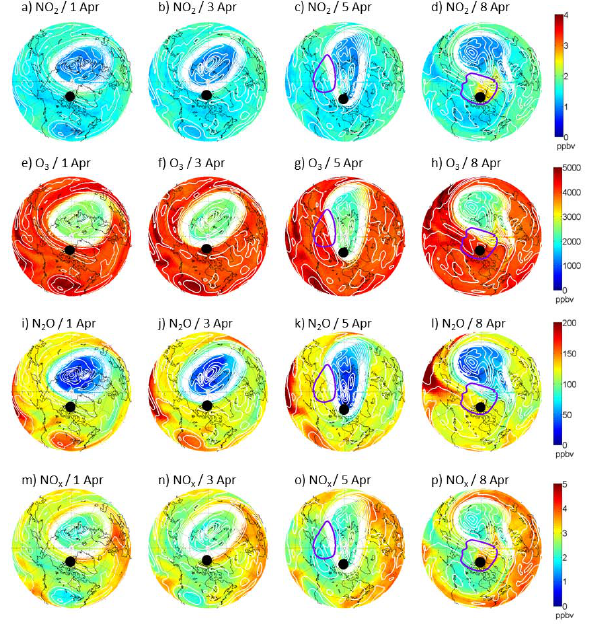
Fig. 6. As for Fig. 5 at the 850-K ( ∼ 31-km) potential temperature level. The area enclosed by the purple contour indicates T > 245K. Note that color scales are different from Fig.